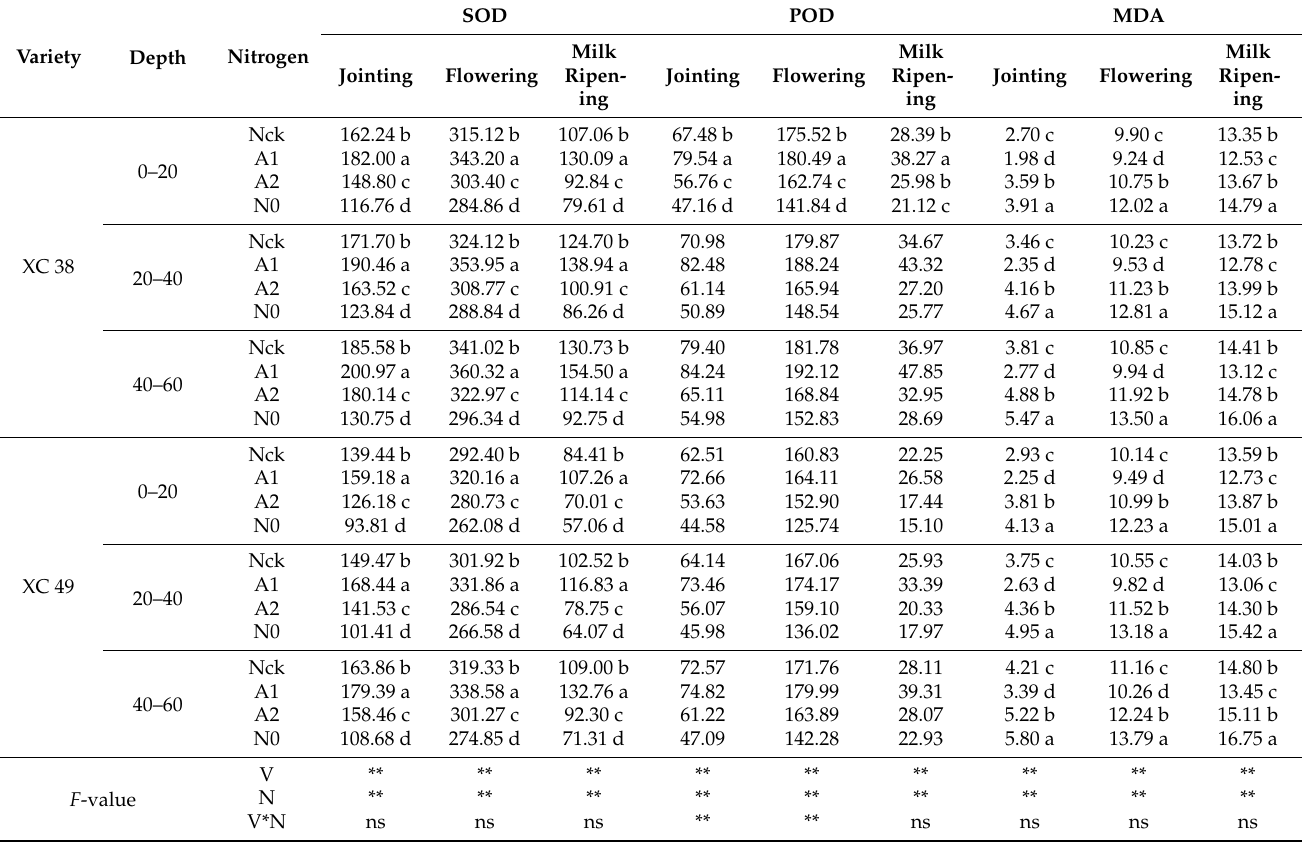
Table 4. Effect of different nitrogen application rates on root antioxidant enzymes activity and MDA content of drip-irrigated spring wheat in